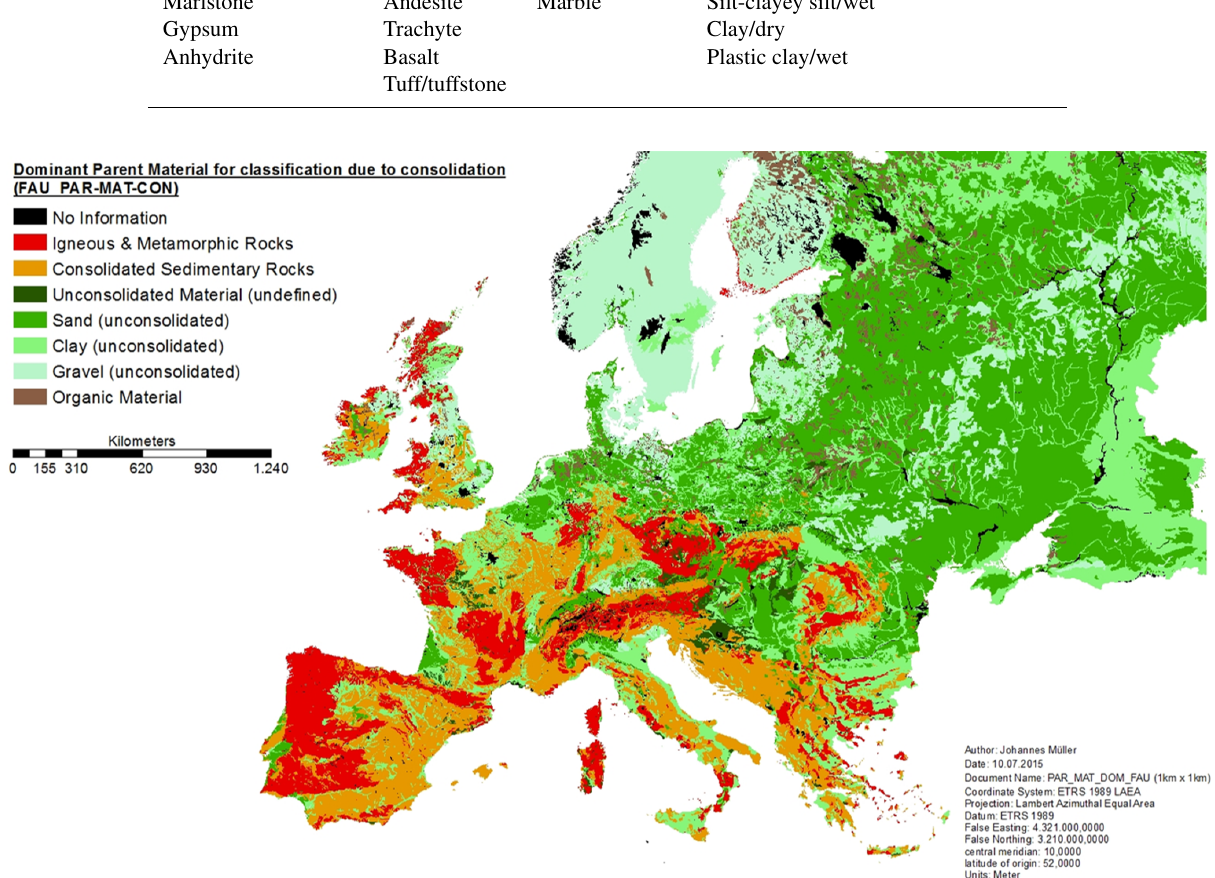
Figure 1. The FAU PAR-MAT-COM European geological map (from Mueller et al., 2018).